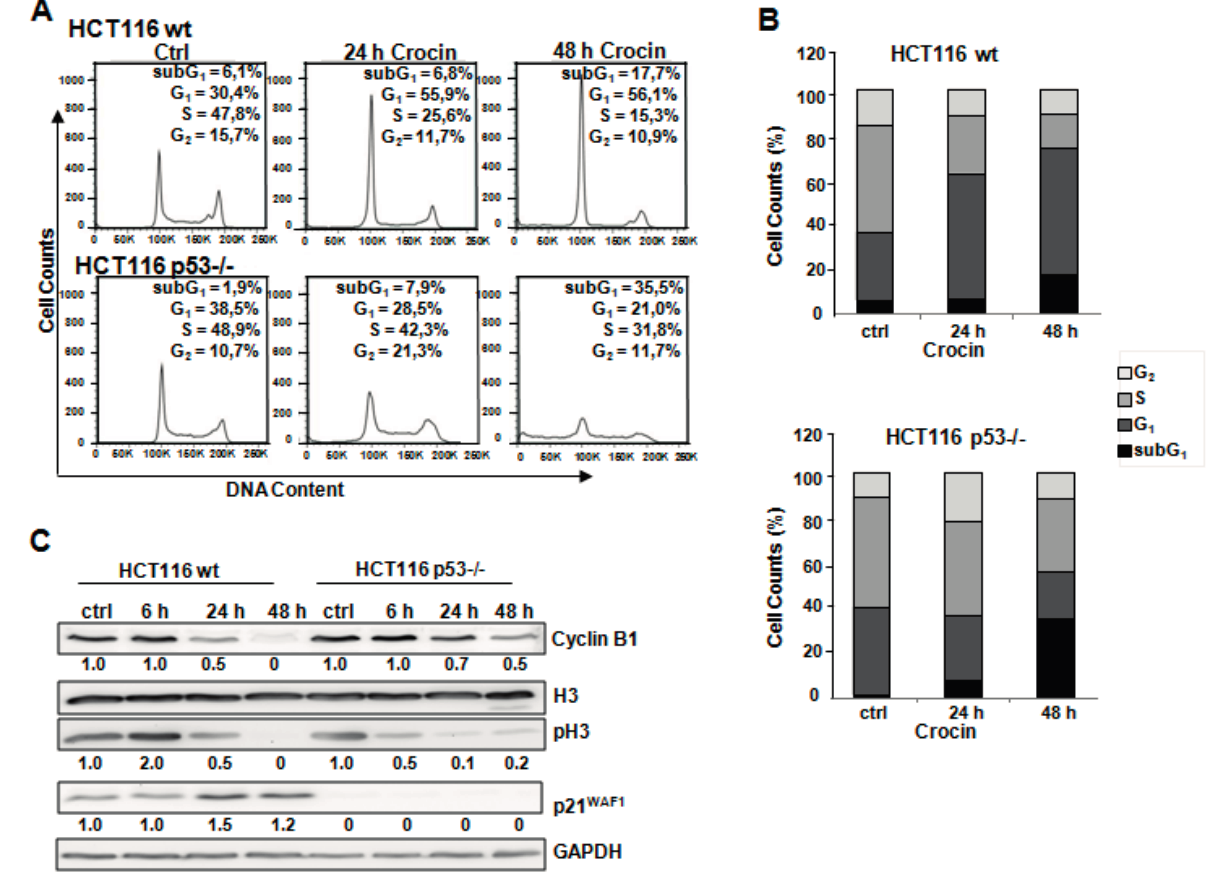
Figure 2. Cell cycle arrest after crocin administration. ( A ) Two cell types, HCT116 wild-type (wt) and HCT116 p53 − / − , untreated (Ctrl) or treated with 10 mM crocin for 24 and 48 h, were harvested and DNA was stained with PI for flow cytometric analysis of DNA content with FACScan flow cytometry; ( B ) Quantitative analysis of percentage gated cells at sub-G 1 , G 1 , S, and G 2 phases in the HCT116 wild-type and HCT116 p53 − / − cells treated with 10 mM crocin for 24 and 48 h; and ( C ) Lysates prepared from two cell types, HCT116 wild-type and HCT116 p53 − / − , untreated (Ctrl) or treated with 10 mM crocin for 6, 24, and 48 h were analyzed by anti-H3, anti-phospho Histone 3 (pH3), anti-Cyclin B1, anti-p21 WAF1 , and anti-GAPDH via Western blotting. GAPDH served as the internal control for equal loading. The ratios represent protein alterations compared to the